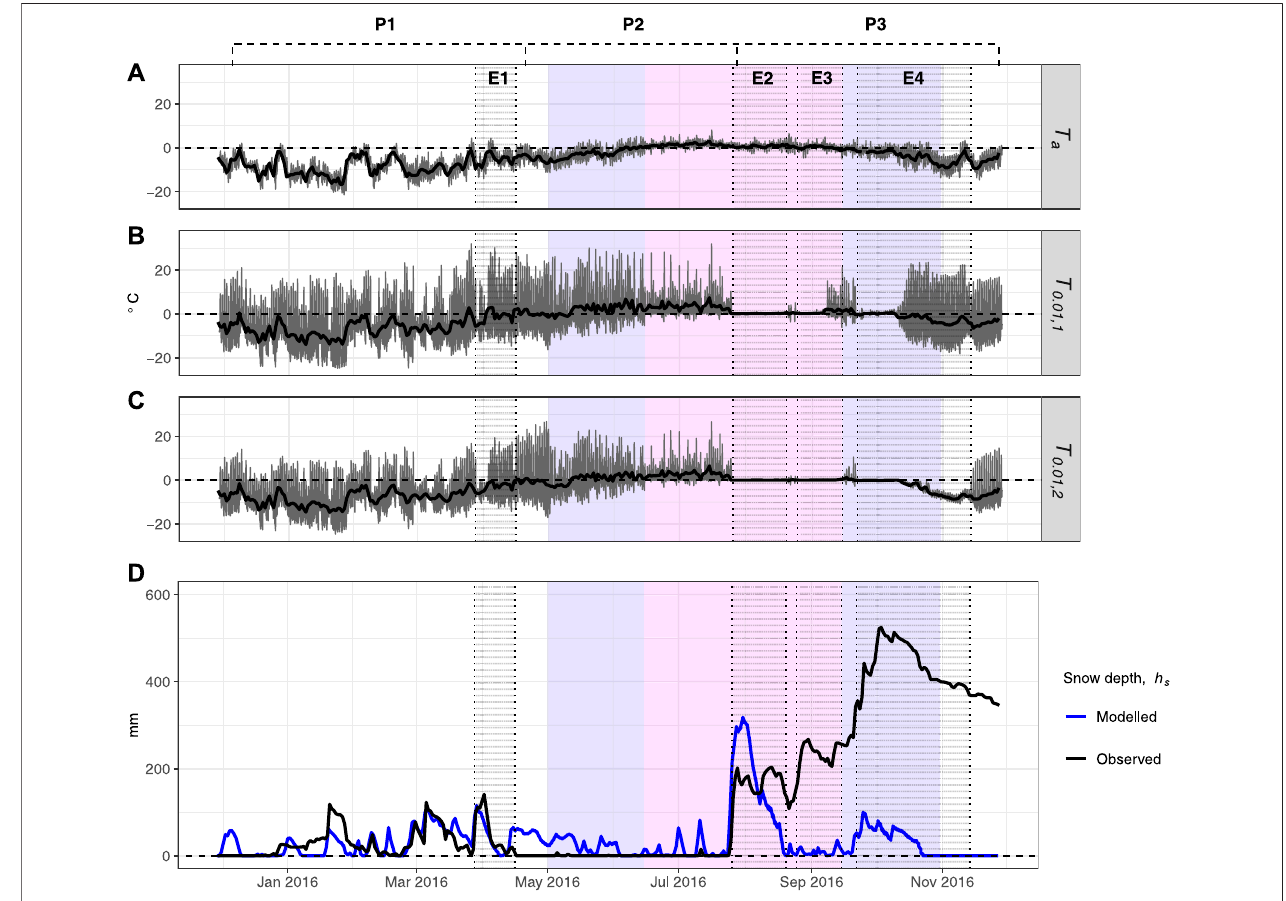
FIGURE 8 | (A) Observed air temperature (B) and (C) observed debris temperature at 0.01 m depth in Pits 1 and 2. Grey lines are hourly data and black lines are daily averages. (D) Daily snow depth from the sonic ranger at NCN-AWS (black), and predicted using SHAW-Glacier (blue). Events that are discussed in the text are highlighted with stippling and labelled E1 - E4; labels P1 - P3 refer to periods with distinct snow cover characteristics. The background colours indicate the seasons, as de fi ned by Government of Nepal (2021): white is winter, pink is monsoon, blue is both pre- and post-monsoon.